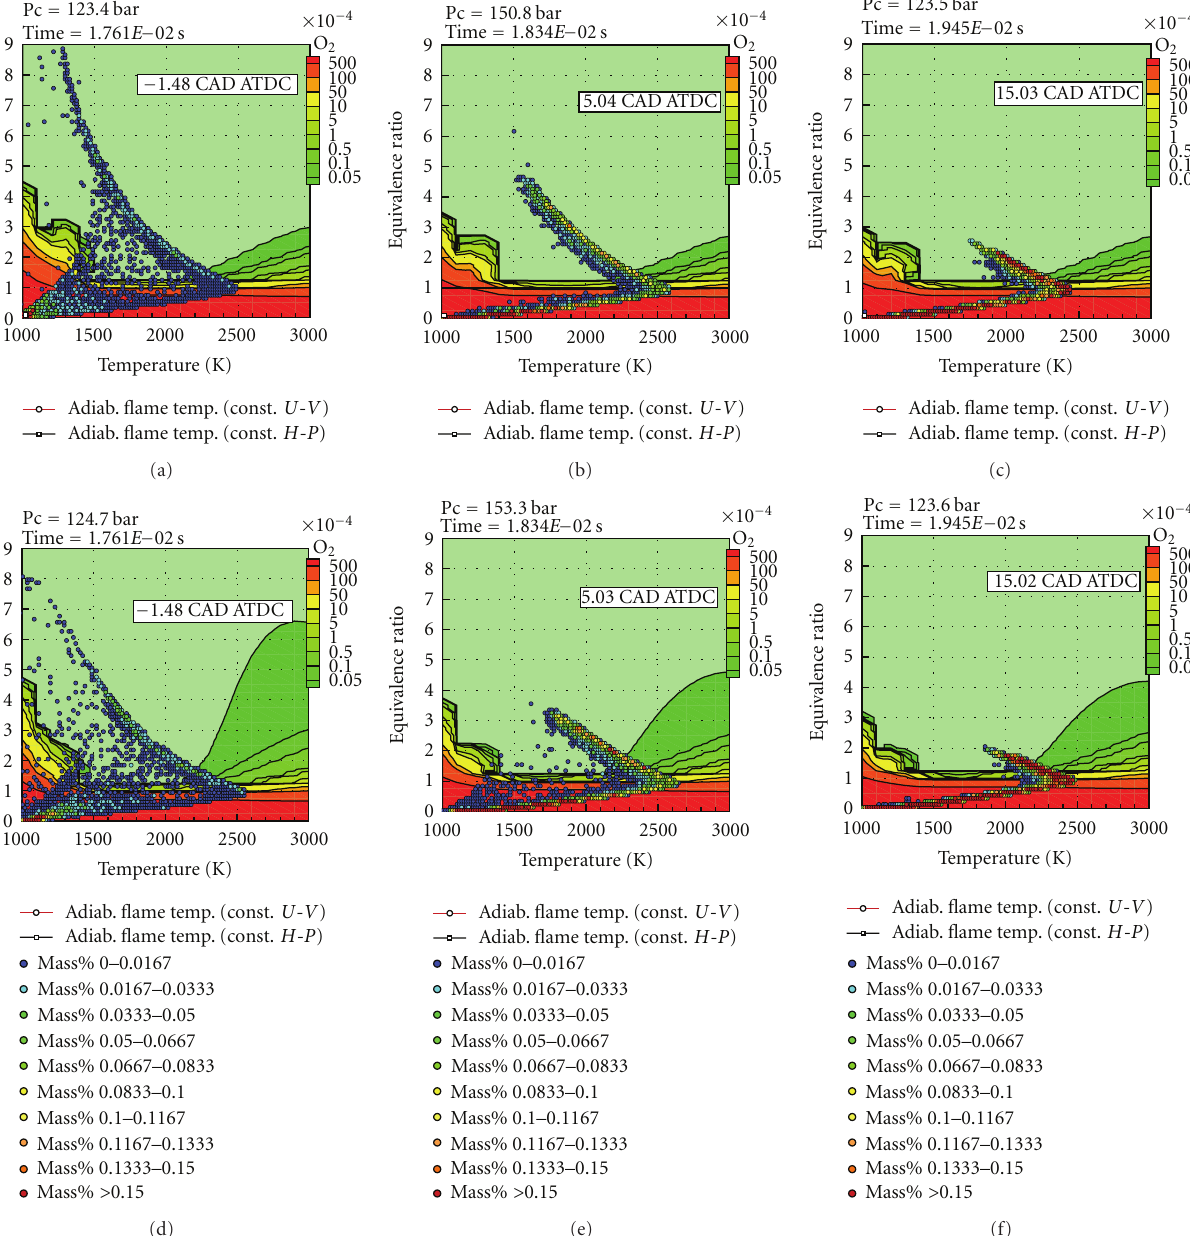
combustion has a much wider and deeper colored (red and yellow) region around the periphery of the reacting mixing compared to diesel oil combustion, which means more NO was formed at this